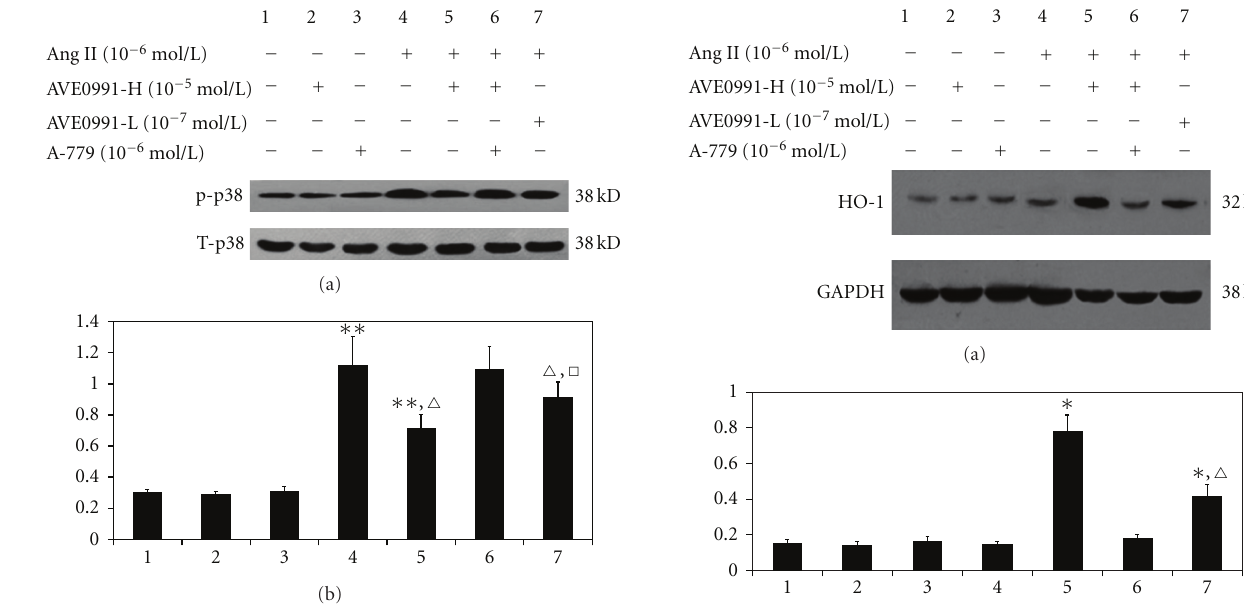
indicates, the level of p38 phosphorylation in the Ang II (10 − 6 mol/L) group was significantly higher than that in the control group. AVE0991 treatment (10 − 5 mol/L) significantly inhibited Ang II-mediated p38 phosphorylation ( n = 8, P